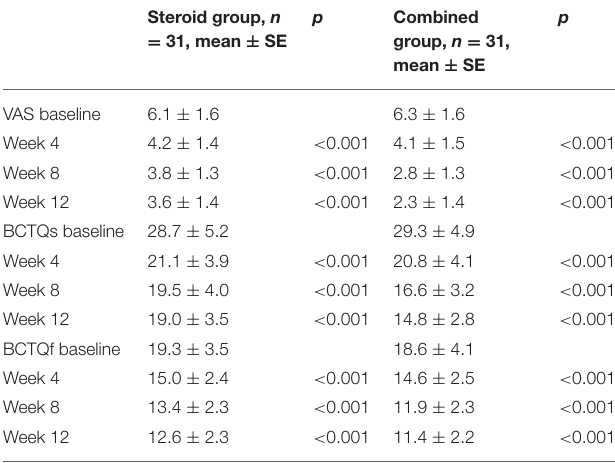
TABLE 3 | The outcome variables (VAS and BCTQ) before and after treatment in both groups. p Combined Steroid group, n = 31, mean ± SE group, n = 31,